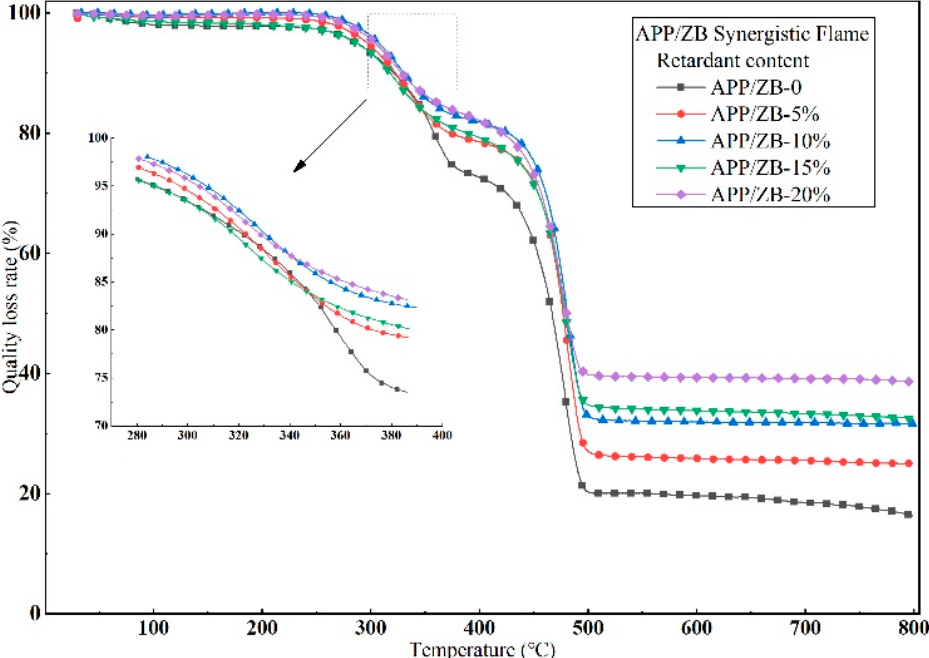
Figure 4. E ff ect of di ff erent APP/ZB content on FWPC thermal weight loss. Figure 4. Effect of different APP/ZB content on FWPC thermal weight Table 3. Characteristic values of TG curve.